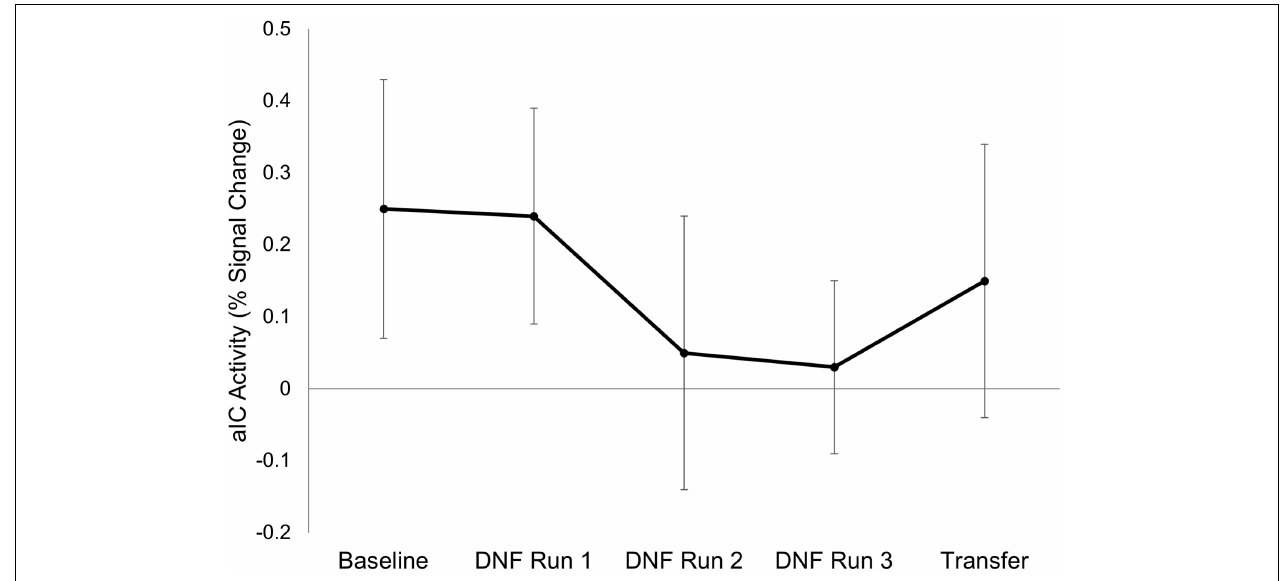
FIGURE 2 | Right anterior insula activity across scanning runs. Mean activation in adolescents’ right anterior insular cortex (aIC) is shown for each scanning run ( n = 6). Error bars represent the standard error of the mean. Neurofeedback was not presented during the Baseline and Transfer runs.